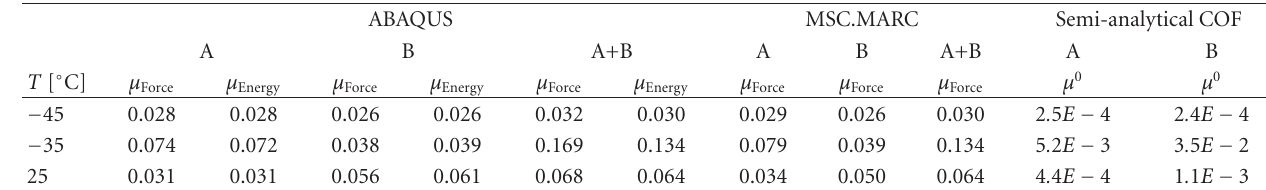
Table 2: Average, steady-state COFs at di ff erent temperatures in case of 10-term Maxwell-model μ interface = 0 . 025. For the definition of μ 0 , see Section 4.2.